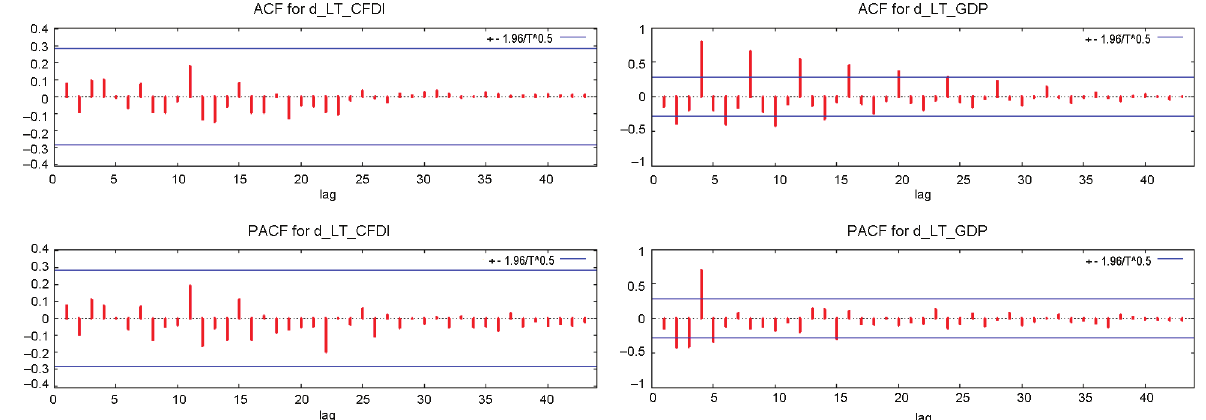
Fig. 11. Time series plots of the first-order integration autocorrelation function (ACF) and partial autocorrelation function (PACF) for Lithuania’s CFDI and the construction’s contribution to GDP